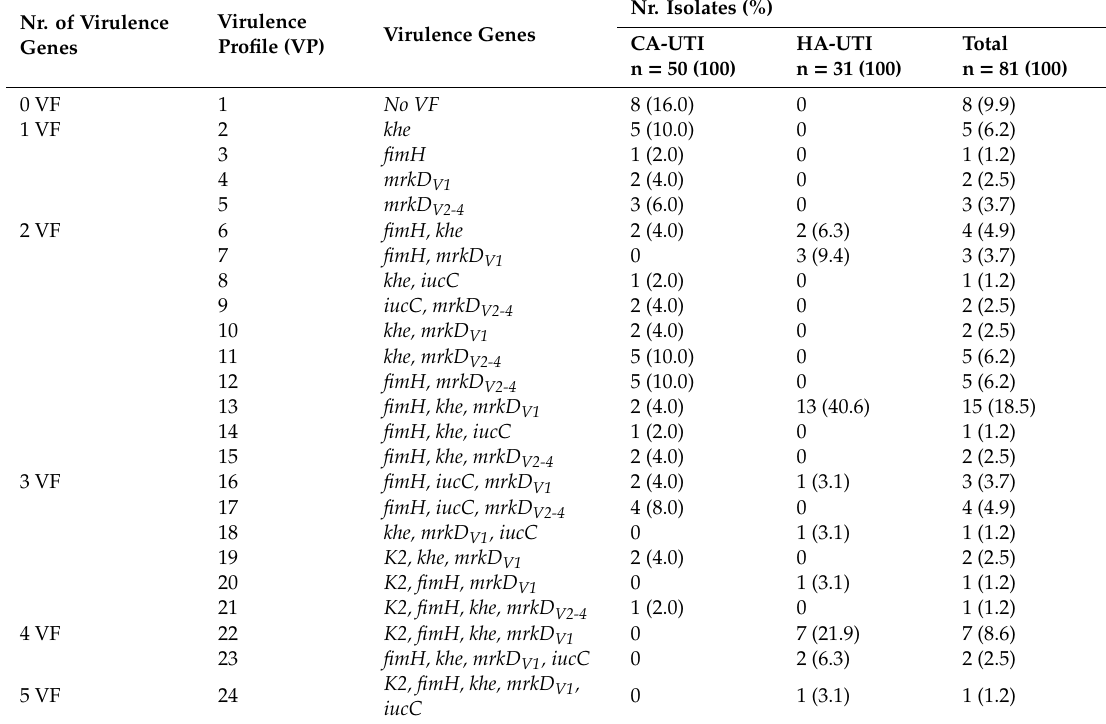
Table 3. Characterization of virulence profiles of community- and hospital-acquired UTI K. pneumoniae